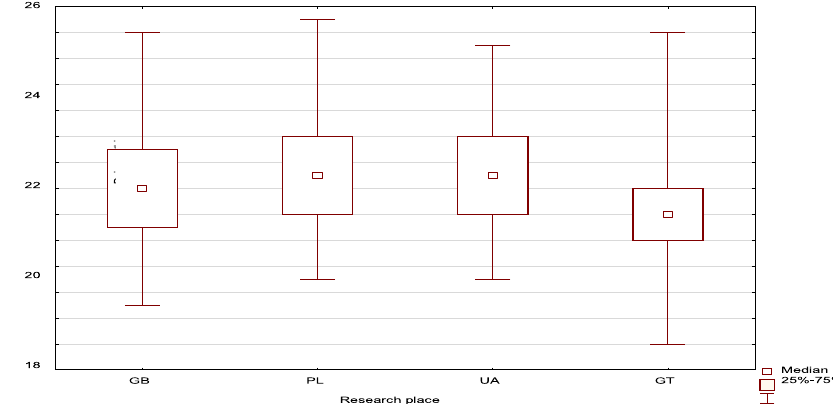
Table 5. Post-hoc tests for doing nothing : Note: Sample n = 441.